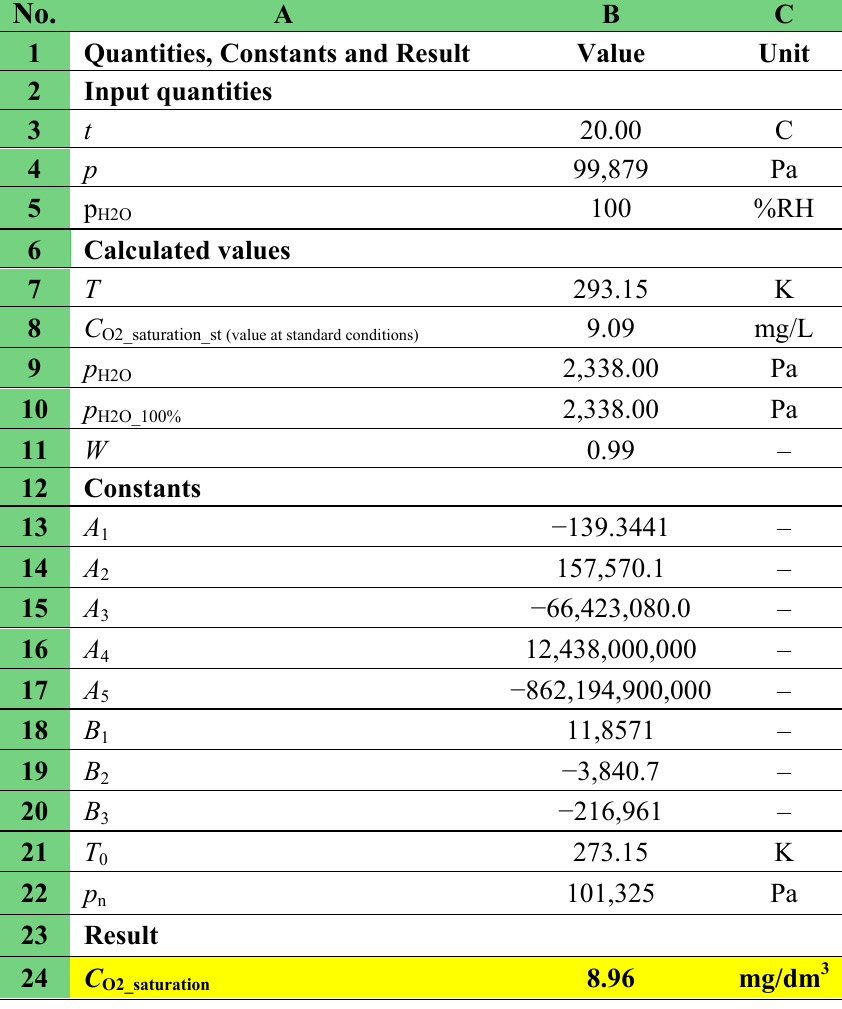
Table A1. Example of Excel spreadsheet for calculation of DO saturation consentration. Values of input quantities will be defined by user.